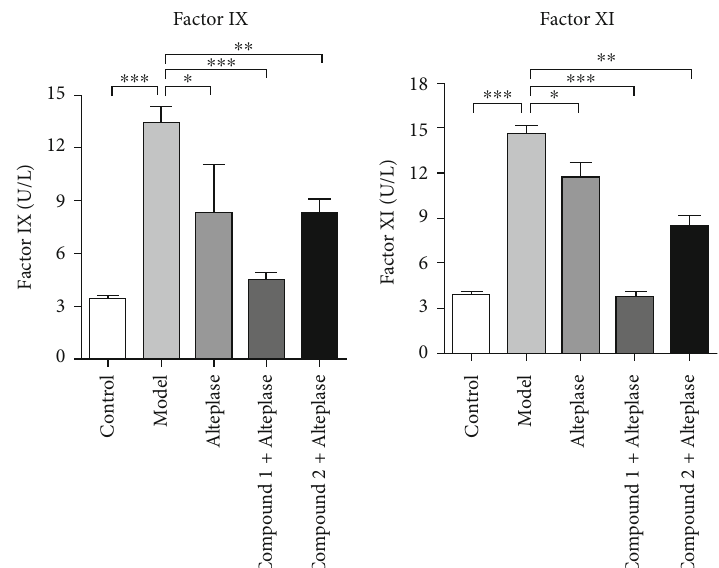
Figure 4: Signi fi cantly reduced content of coagulation factors in the serum after compound treatment. The cerebral infarction animal model was constructed and the compound was injected for treatment at the concentration of 5 mg/kg. The content of coagulation factors in the serum was fi rstly conducted to measure with ELISA assay.